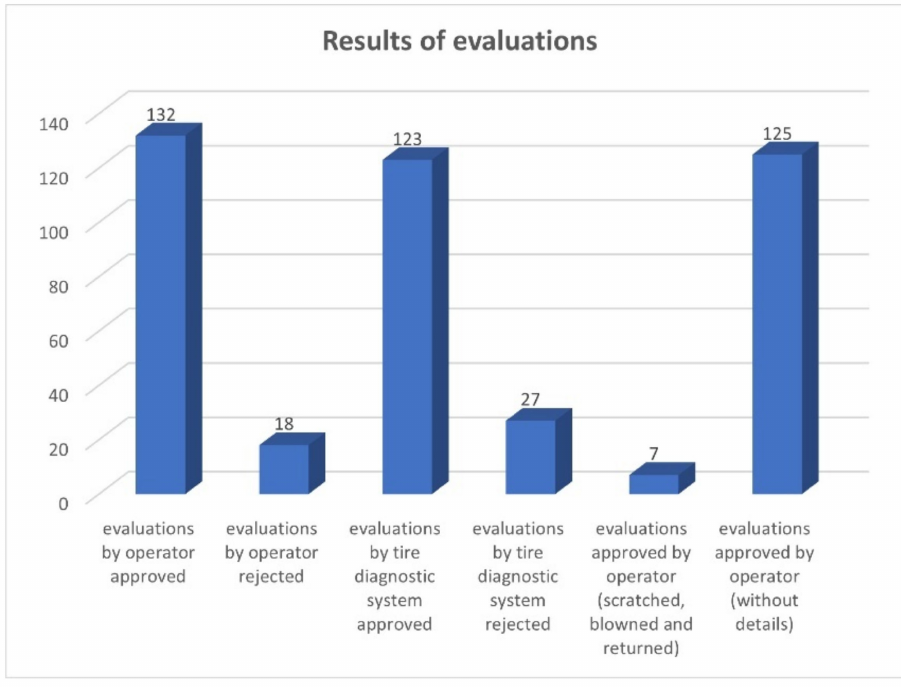
Figure 10. Results of